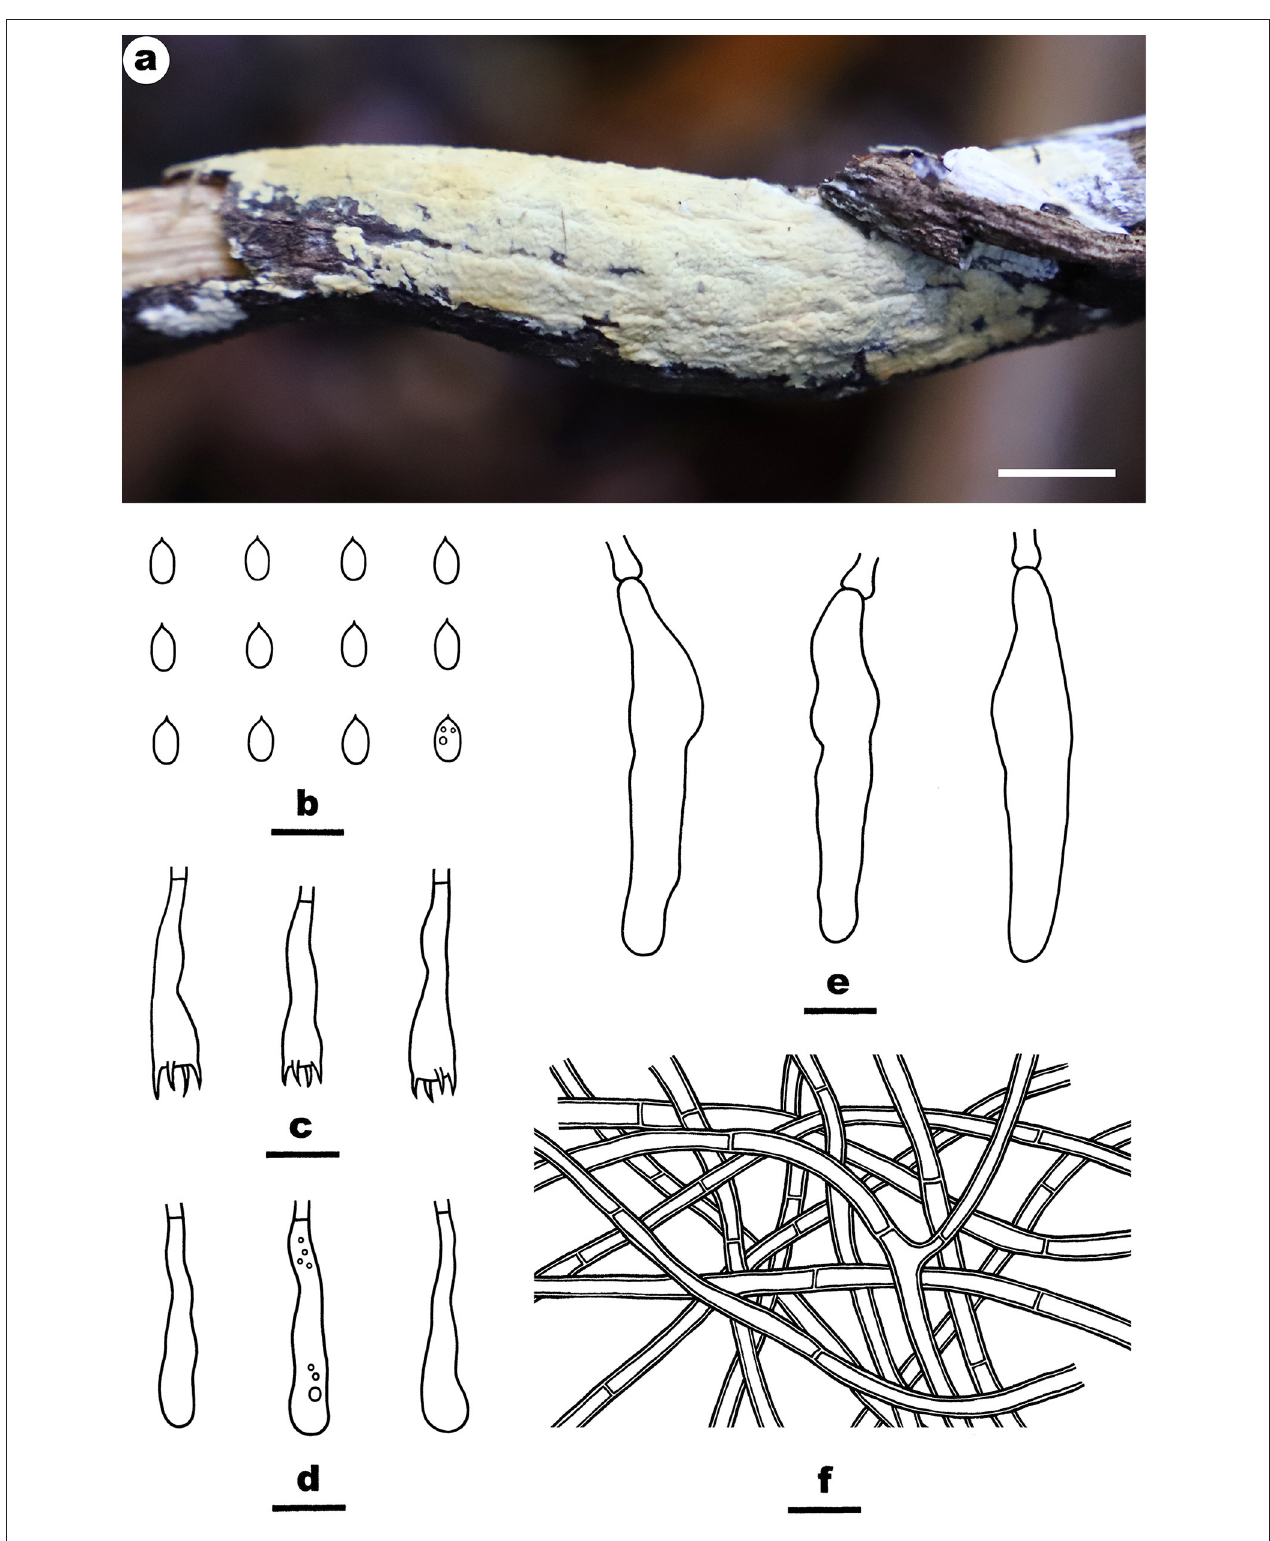
FIGURE 4 | Efibula hainanensis (from the holotype He 6004; scale bars: a = 1cm; b–f = 10 µ m). (A) Basidiomata. (B) Basidiospores. (C) Basidia. (D) Basidioles. (E) Cystidia. (F) Hyphae from subiculum.